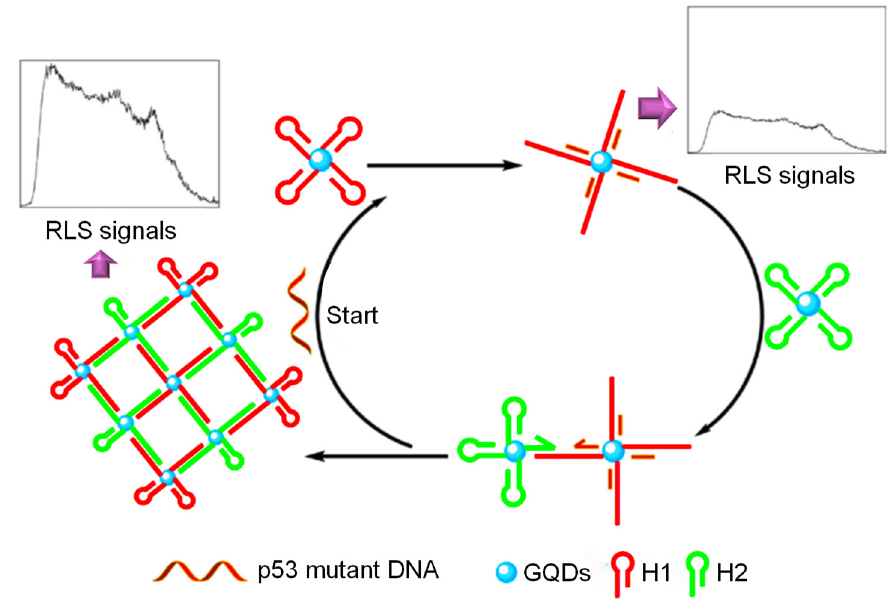
Figure 31. The mechanism of RLS of GQDs for detecting mutant DNA based on catalytic hairpin assembly amplification approach [363].